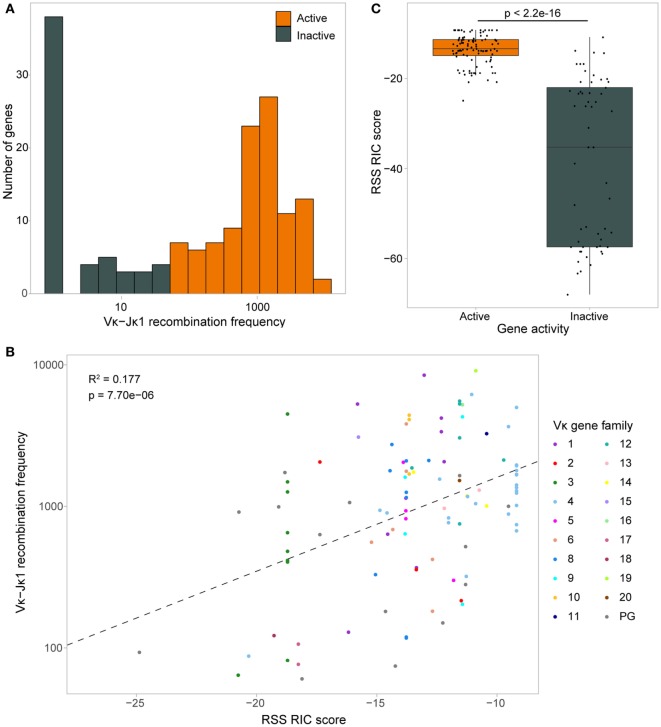
Recombination signal sequence (RSS) Information Content (RIC) score can only partially explain variation in Vκ gene activity. (A) Distribution of Vκ-Jκ1 recombination frequencies for all 162 Vκ genes. A one-sided binomial test was used to gauge the significance of their recombination frequency, allowing each gene to be labelled as active (fdr adjusted p-value <0.01) or inactive. (B) Dependence of active genes’ recombination frequency on RSS RIC score. Linear regression model (dashed line) reveals that only 17.7% of the variation in recombination frequency of active genes can be explained by the RIC score. (C) RSS RIC scores of active and inactive Vκ genes; p-value from a two-sided Wilcoxon rank sum test.